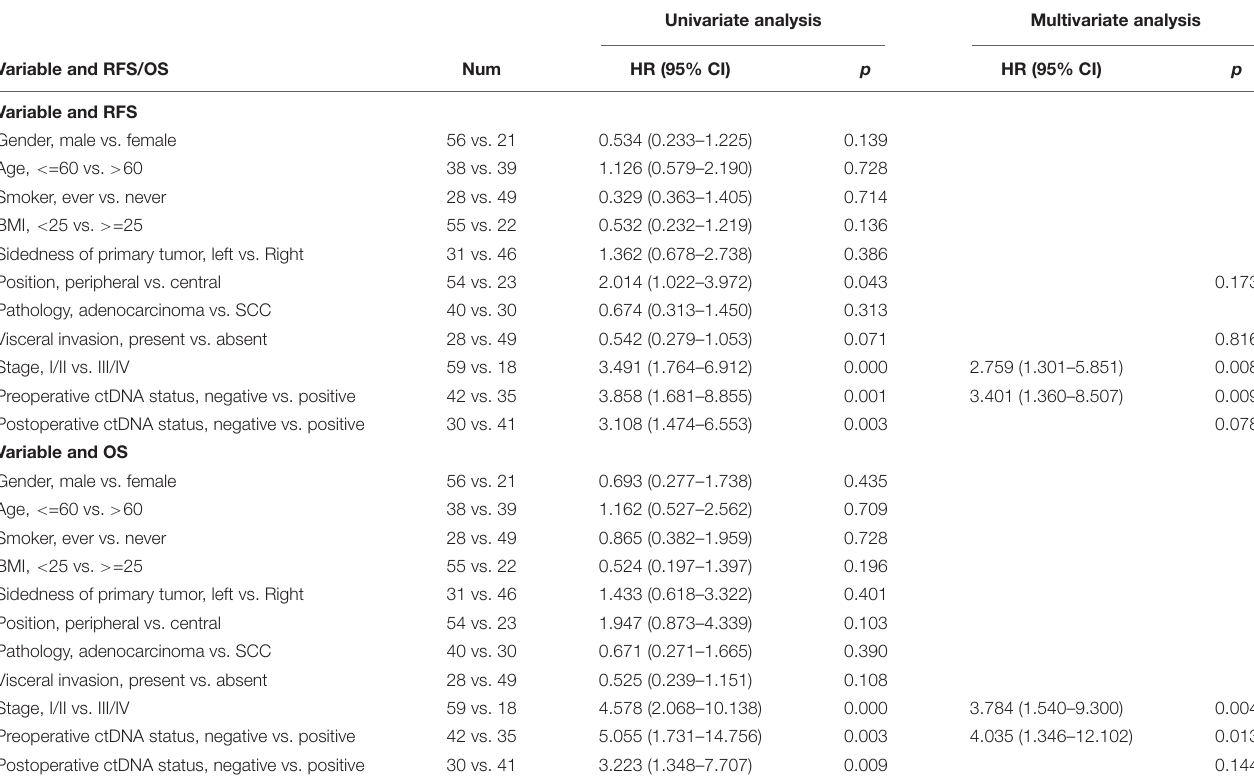
TABLE 2 | Recurrence-free survival (RFS) and overall survival (OS) analysis by clinicopathologic variables and pre- and post-operative ctDNA status. Univariate analysis Multivariate